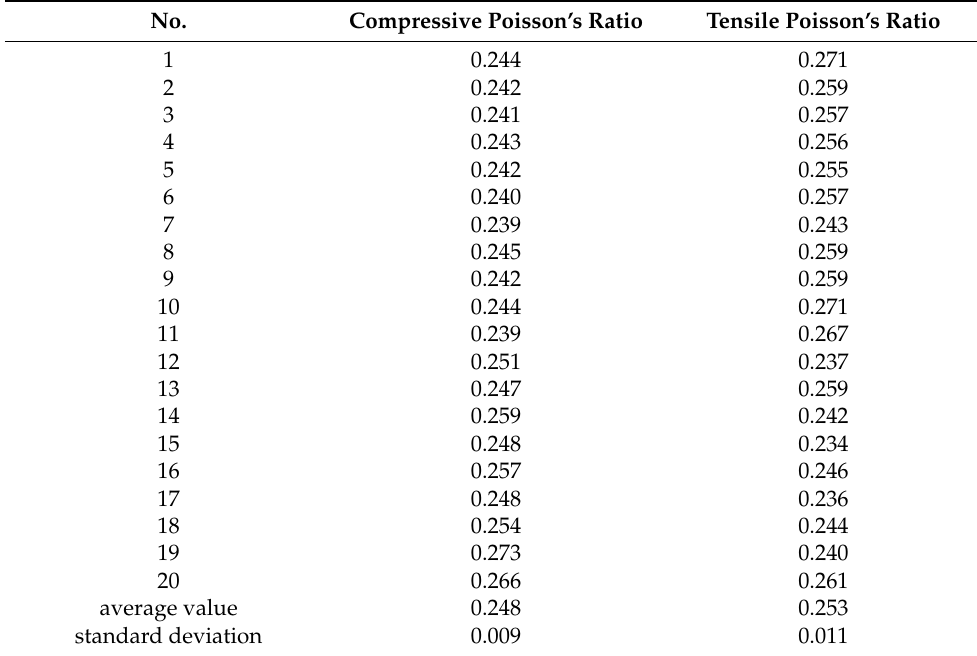
Table 7. Poisson’s ratio statistics of structural grout materials.